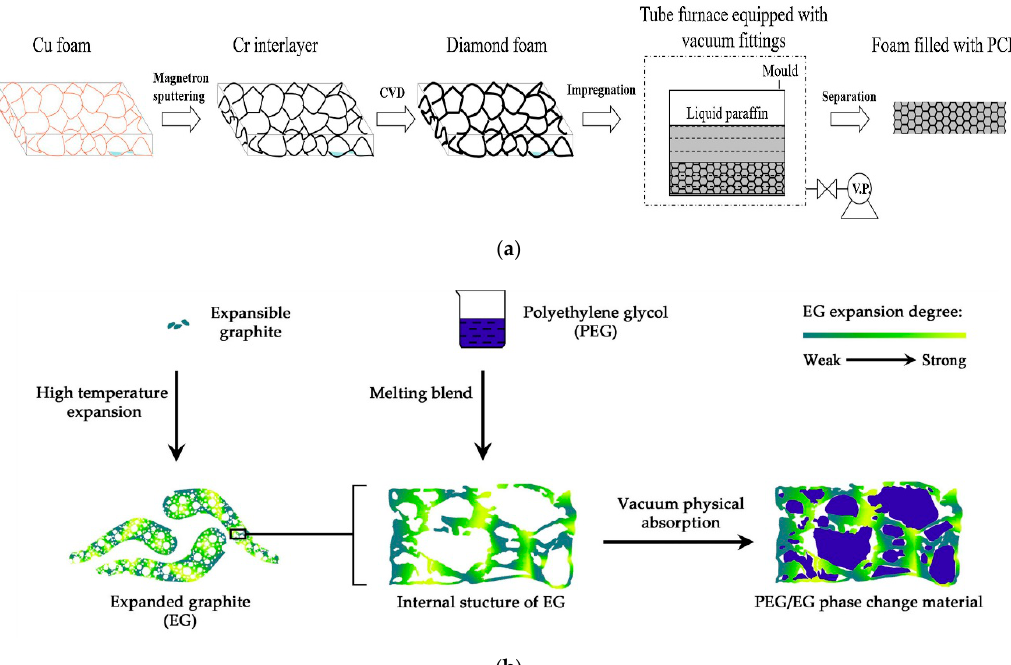
Figure 22. ( a ) The fabrication procedure of diamond foam and the generated composite phase change material (CPCM), adopted from Ref. [259]; ( b ) The synthetic route of polyethylene glycol/expanded graphite (PEG/EG), adopted from Ref. [262].